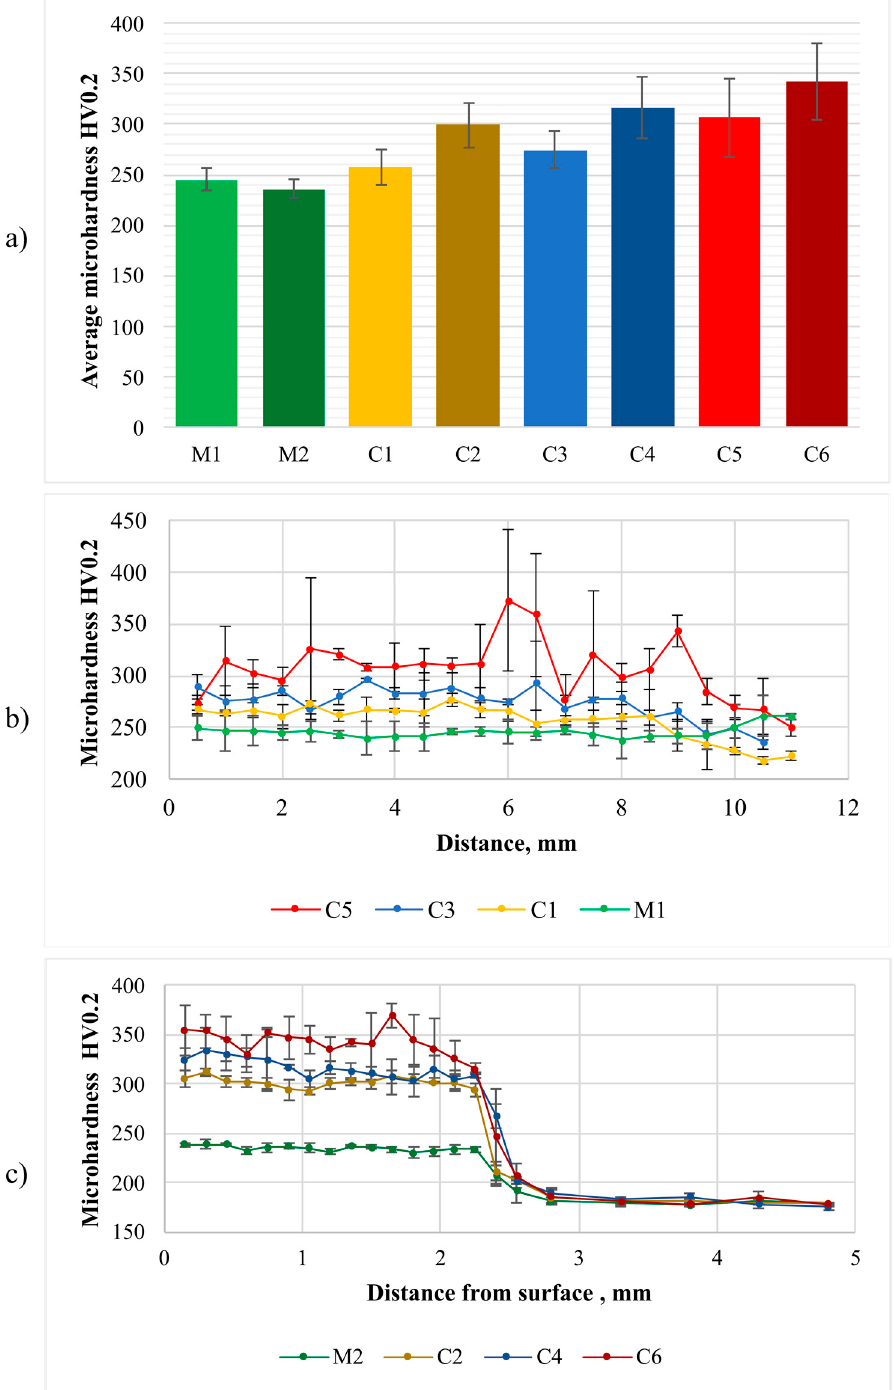
Figure 10. Vickers microhardness test results: ( a ) average microhardness, ( b ) microhardness distribution across the beads (in accordance with Figure 1a) and ( c ) microhardness distribution from the surface to the base material (in accordance with Figure 1b); designations in accordance with Table 3.